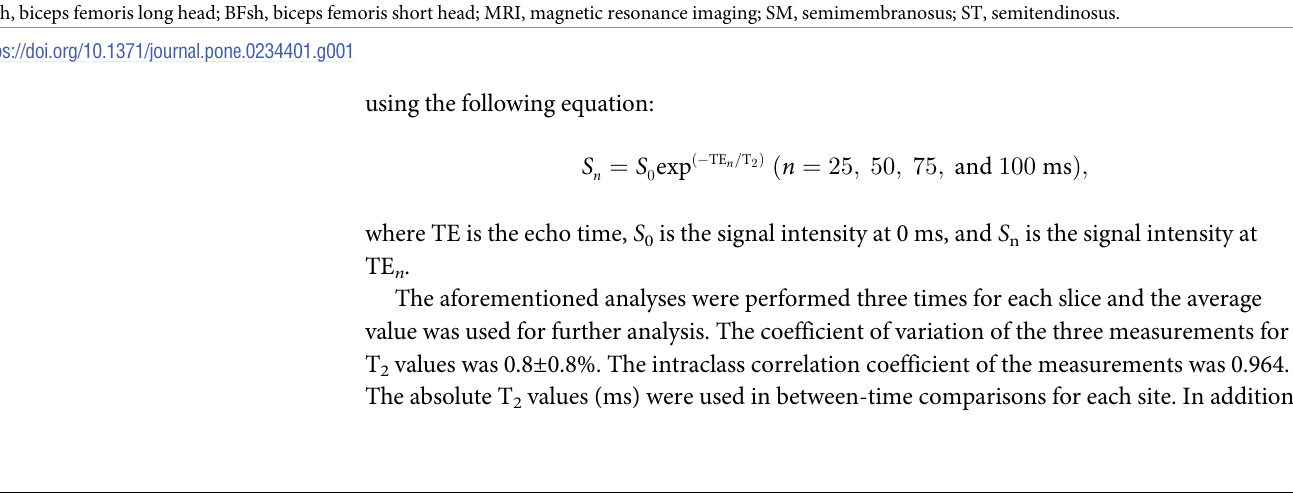
PLOS ONE | https://doi.org/10.1371/journal.pone.0234401 June 25,